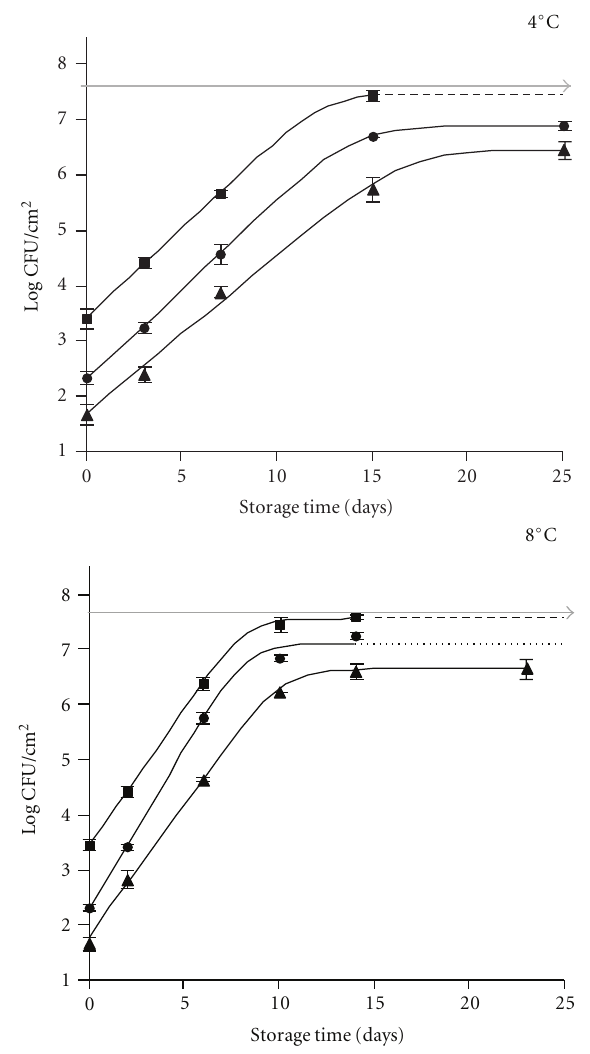
Figure 2: Changes in the lactic acid bacteria counts of marinated pork loin slices subjected to E-beam treatment and stored at 4 ◦ C and 8 ◦ C. Control ( (cid:2) ), treated at 1 ( • ), and 2kGy ( (cid:3) ).